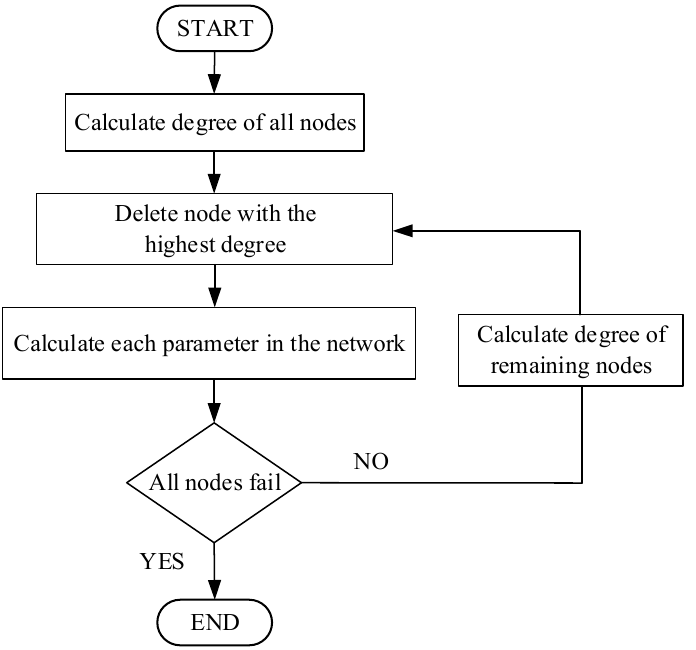
Figure 2. The process of real-time degree priority attack.